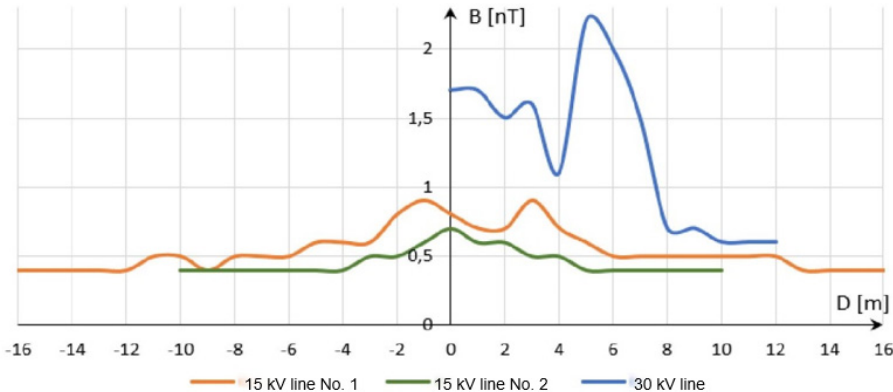
Figure 5. Distribution of magnetic field induction B across the line for measuring point No. 2, and the VLF frequency range (induction measuring methodology as in Figure 2).